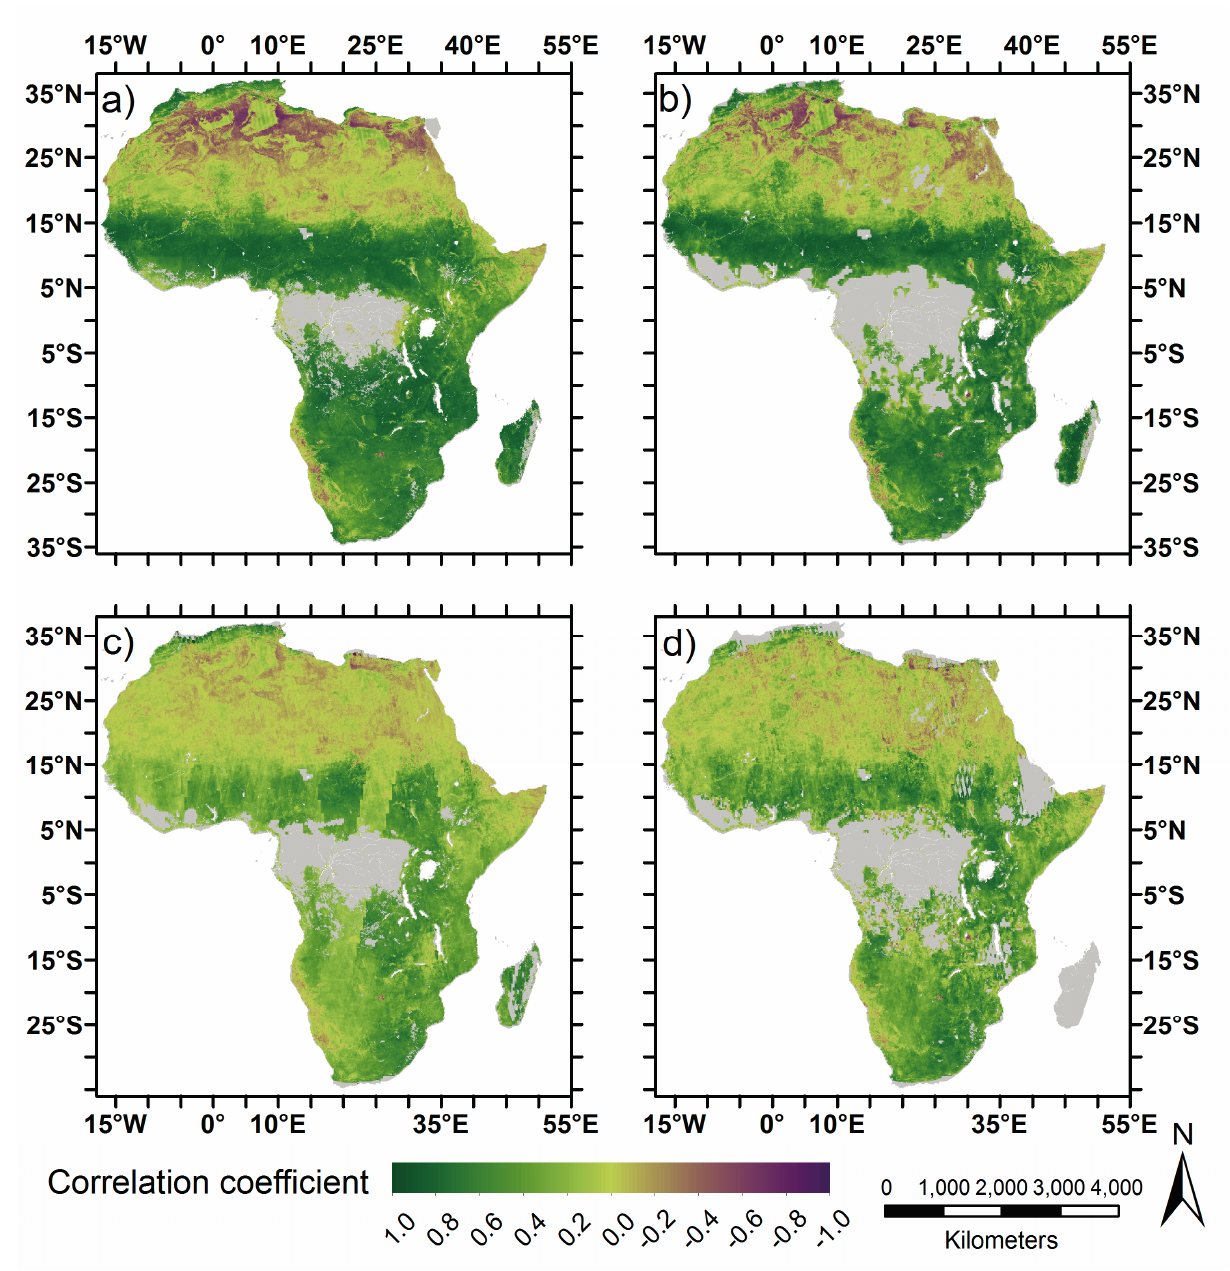
Figure 3. ( a , b ) The correlation coefficient between the Advanced Synthetic Aperture Radar (ASAR) Global Monitoring (GM) (original Surface Soil Moisture (SSM) values) and Noah model from the Global Land Data Assimilation System (GLDAS-NOAH) SSM and Advanced Microwave Scanning Radiometer for Earth Observing System (AMSR-E) SSM, respectively; ( c , d ) the correlation coefficient between ASAR GM (SSM anomalies) and GLDAS-NOAH SSM and AMSR-E SSM, respectively. The grey color represents the masked areas (rain forests and urban areas) or areas with insufficient data coverage (below 50 data